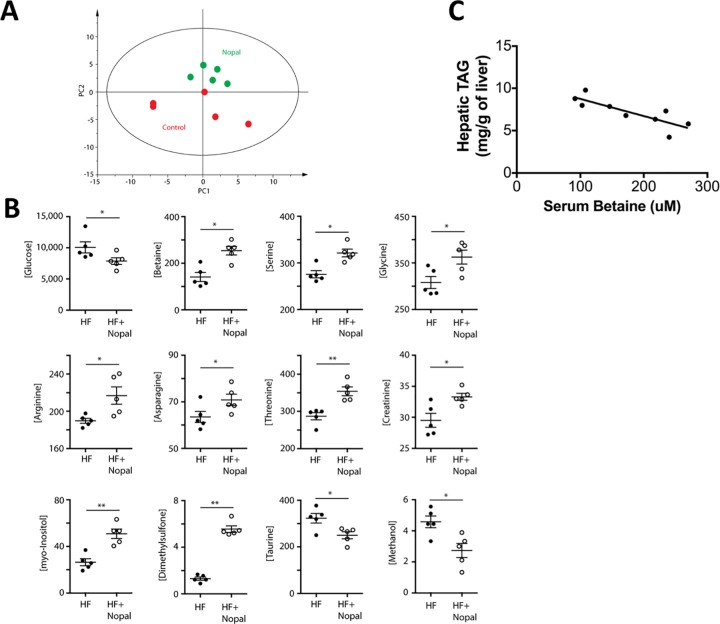
Impact of Nopal on serum metabolites of HF-fed rats.A) Principal Component Analysis (PCA) revealed distinct separation between serum metabolomic profiles from rats fed a HF diet (red) or a HF + nopal diet (green) (R2X = 0.68; Q2 = 0.12). B) Serum metabolite concentrations (in micromoles/L). Significance is based on Mann-Whitney non-parametric analysis, and is set at p < 0.1 (n = 5 per group). C) Serum betaine levels correlate negatively with hepatic triglyceride levels (R2 = -0.67; p = 0.007).